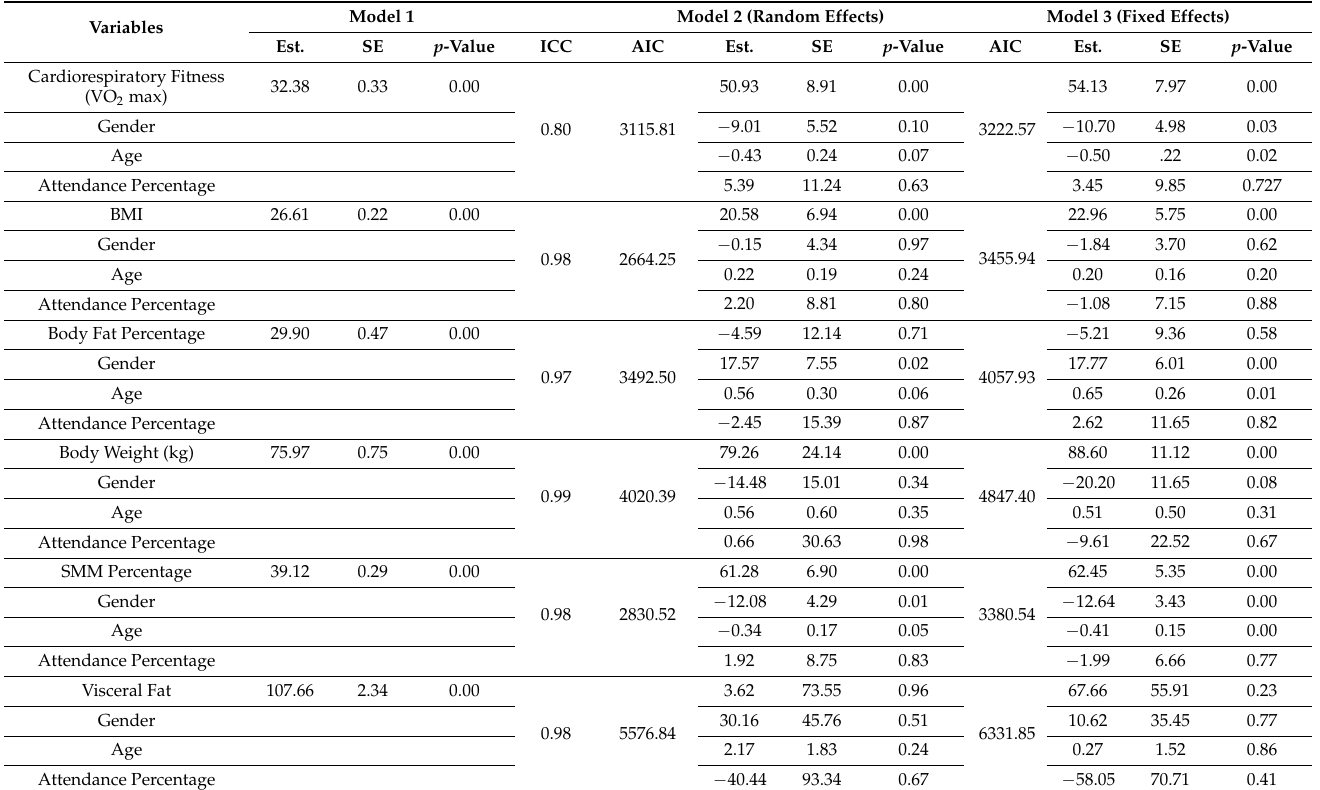
Table 3. Linear mixed model analysis of the predictors of physiological health.